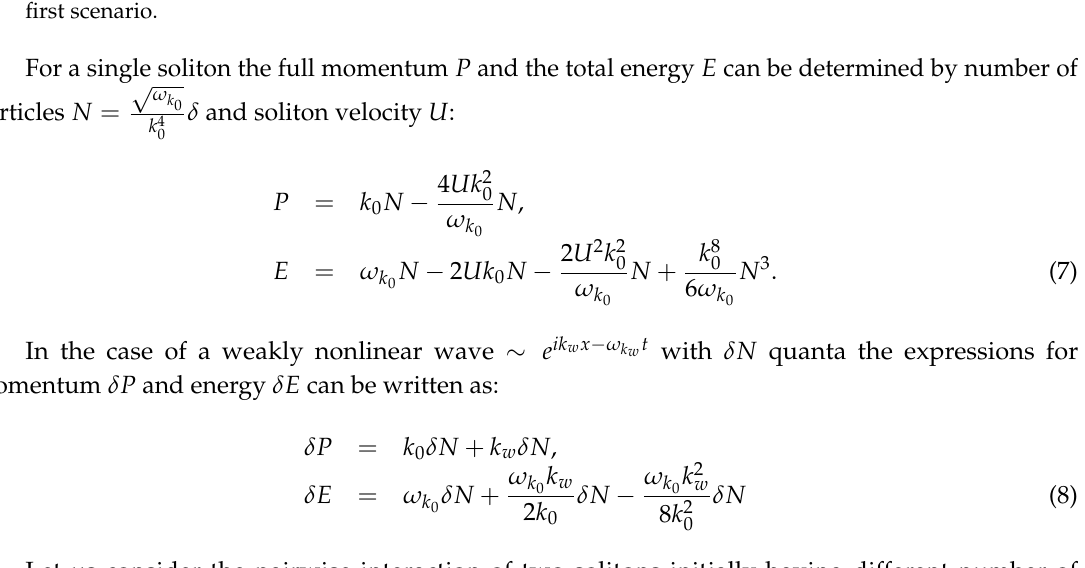
Figure 2. Time dependence for number of particles ( a ), momentum ( b ) and wave number ( c ) in the first